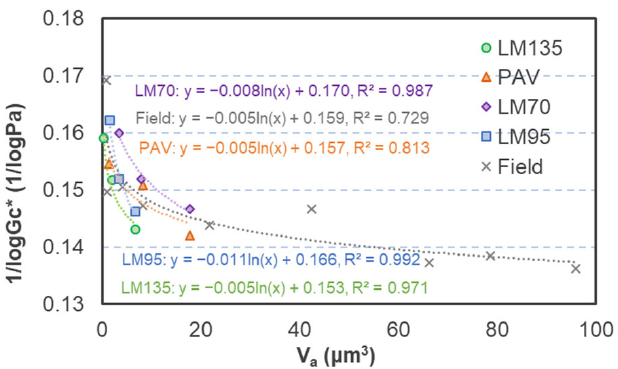
Figure 9. Relationship between the crossover modulus and the fluorescence volume.